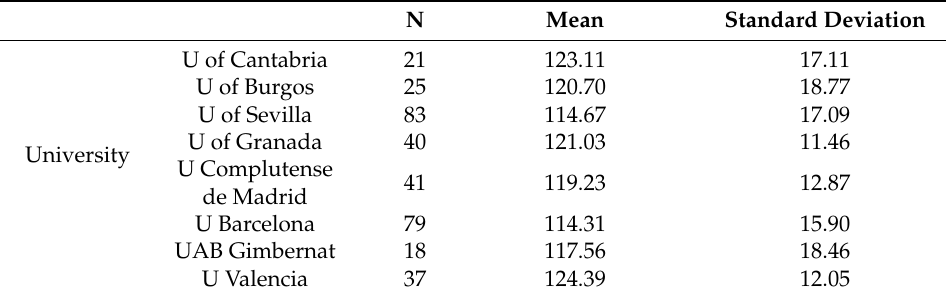
Table 2. Score descriptors on the EBE-STUDENT questionnaire for each university